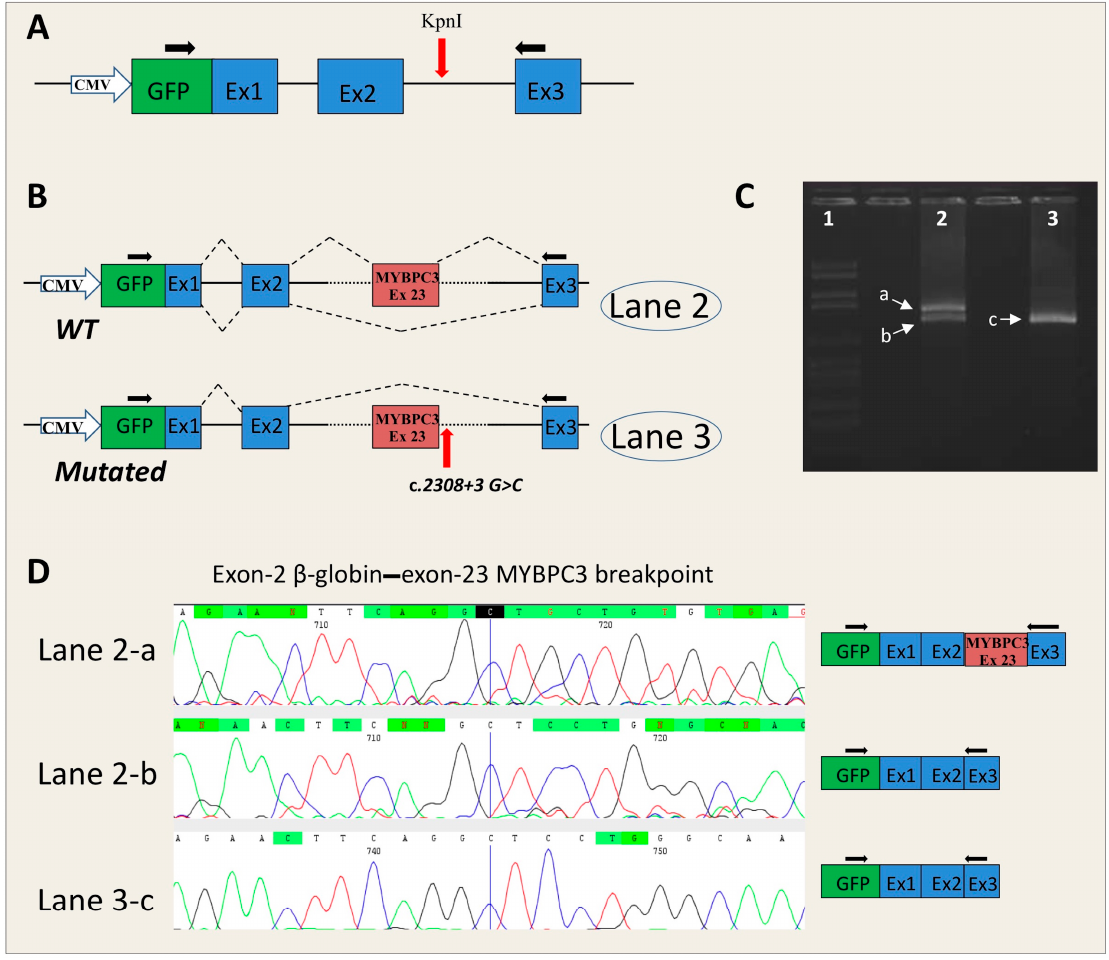
Figure 2. Effect of the MYBPC3 ‐ c.2308+3G>C mutation on the splicing mechanism. ( A ) Schematic representation of the pMGene empty vector. The GFP coding sequence (green box) is fused with exon 1 of the human β‐ globin. The exons of human β‐ globin are shown in blue boxes. The red arrow shows the position of the KpnI restriction site where the insert, containing the exon and the 5 ′ and 3 ′ intronic flanking regions, was cloned. The black arrows indicate the primers used for PCR analysis; ( B ) Schematic representation of the splicing process in pMGene ‐ MYBPC3 constructs (WT, upside; mutated, downside). The red arrow indicates the position of the mutation. The blue boxes represent the exons of human β‐ globin, the red box represents the MYBPC3 ‐ exon 23 cloned in the pMGene vector; ( C ) Electrophoresis of the RT ‐ PCR analysis of mRNA extracted from cell lines transfected with pMGene ‐ MYBPC3 (WT or mutated). Lane 1 : Marker VI (Roche Diagnostics); Lane 2 : pMGene ‐ MYPC3 ‐ WT; Lane 3 : mutated pMGene ‐ MYBPC3 ; ( D ) Electropherograms obtained from the DNA sequencing of fragments a, b, and c (right) extrapolated from panel B and relative splicing results (Black, red, green and blue peaks represent the G, T, A, and C bases, respectively). The blue line in the electropherograms shows the end of exon 2 of β‐ globin.